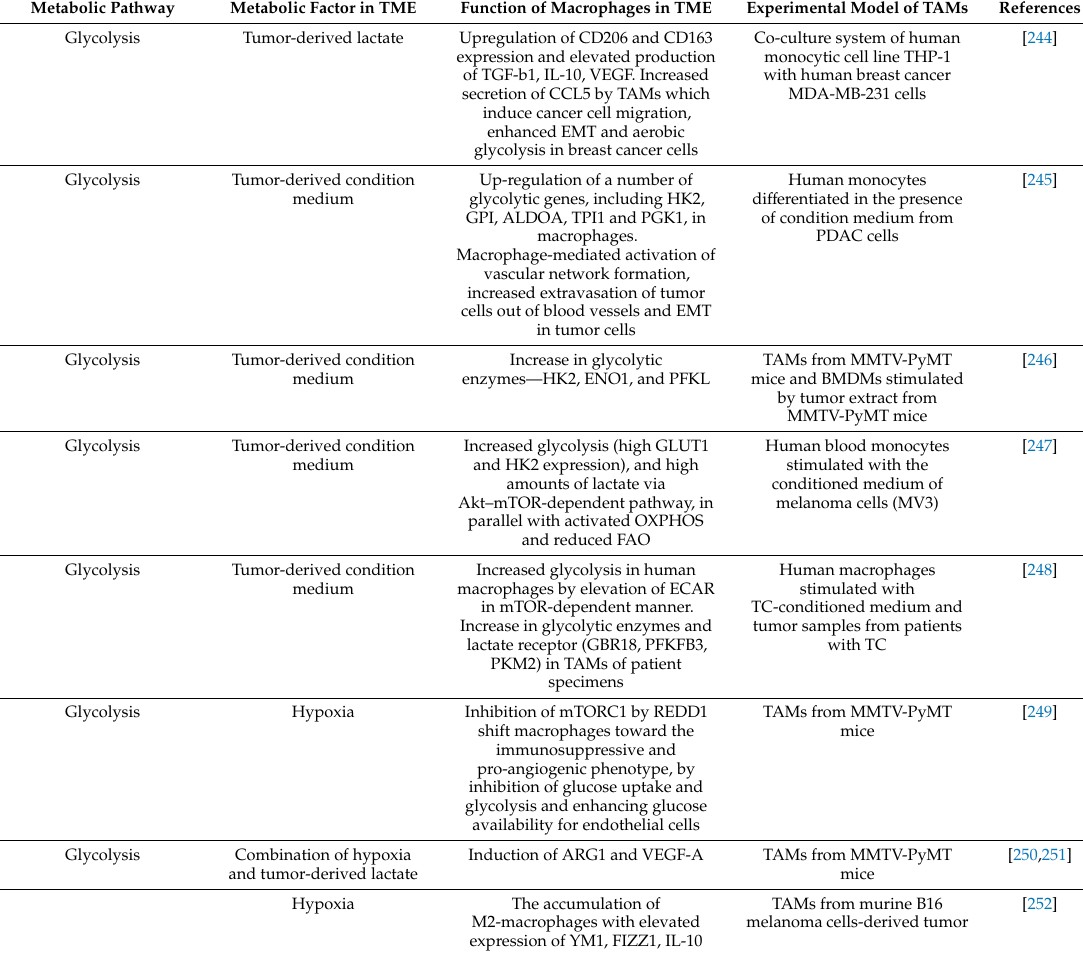
Table 4. TAM reprogramming by tumor-derived metabolic